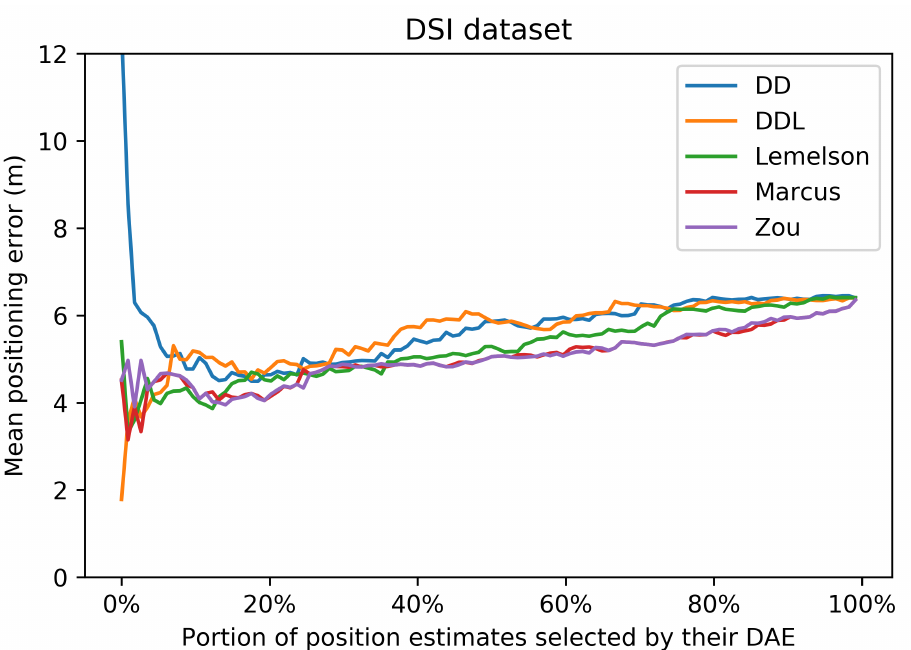
Figure 19. In this plot, the horizontal axis represents the percentage of location estimates selected based on their ranking according to the DAE values. The ranking of each DAE method is depicted with a different color. The vertical axis reports the respective mean positioning error for each selected portion of the original dataset. The values correspond to the validation set of the DSI